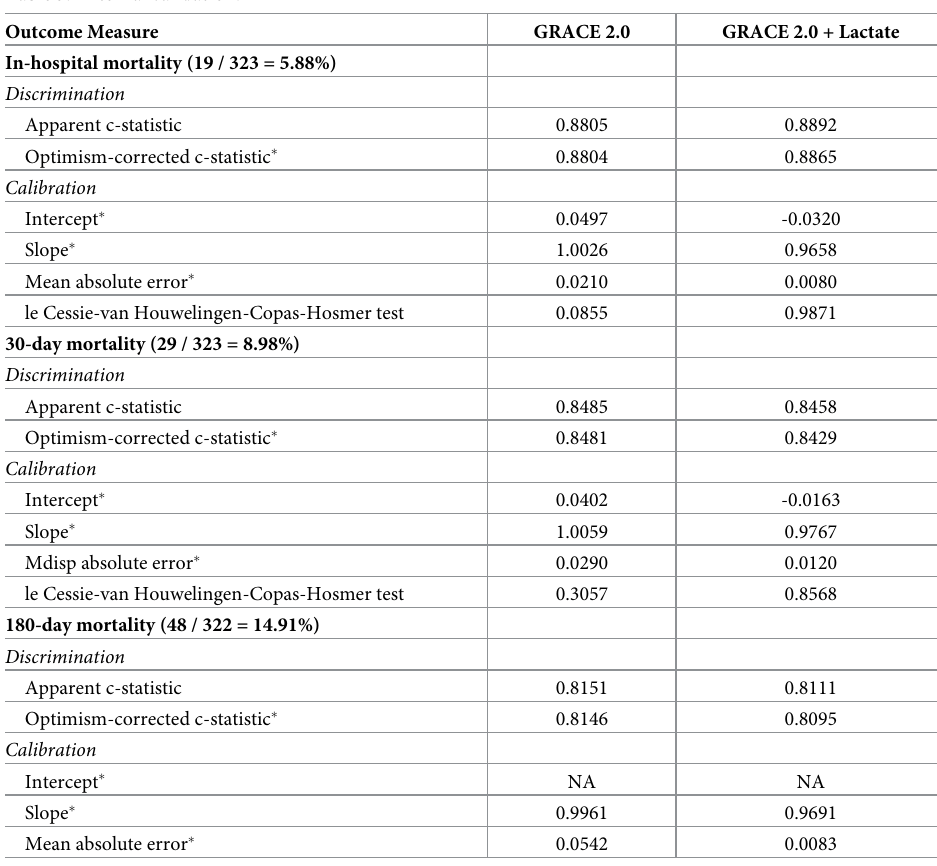
Table 3. Internal